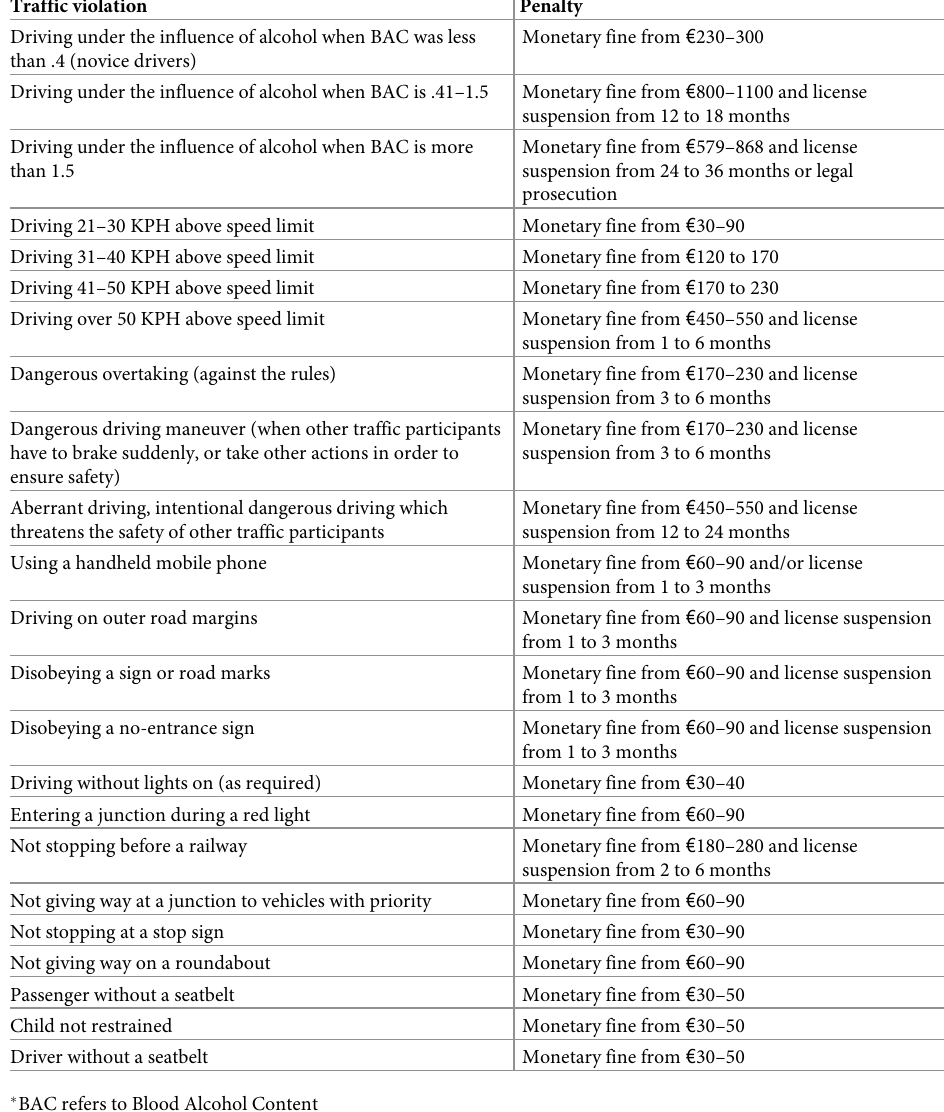
Monetary fine from € 230–300 suspension from 12 to 18 months